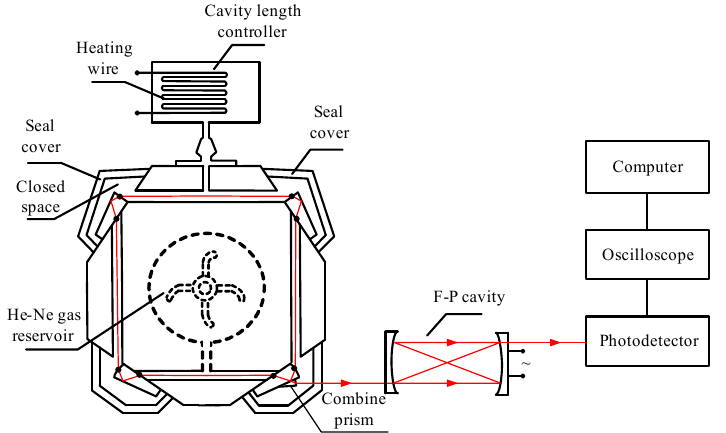
Figure 6. Experimental system of the prism gyro intensity tuning curve.